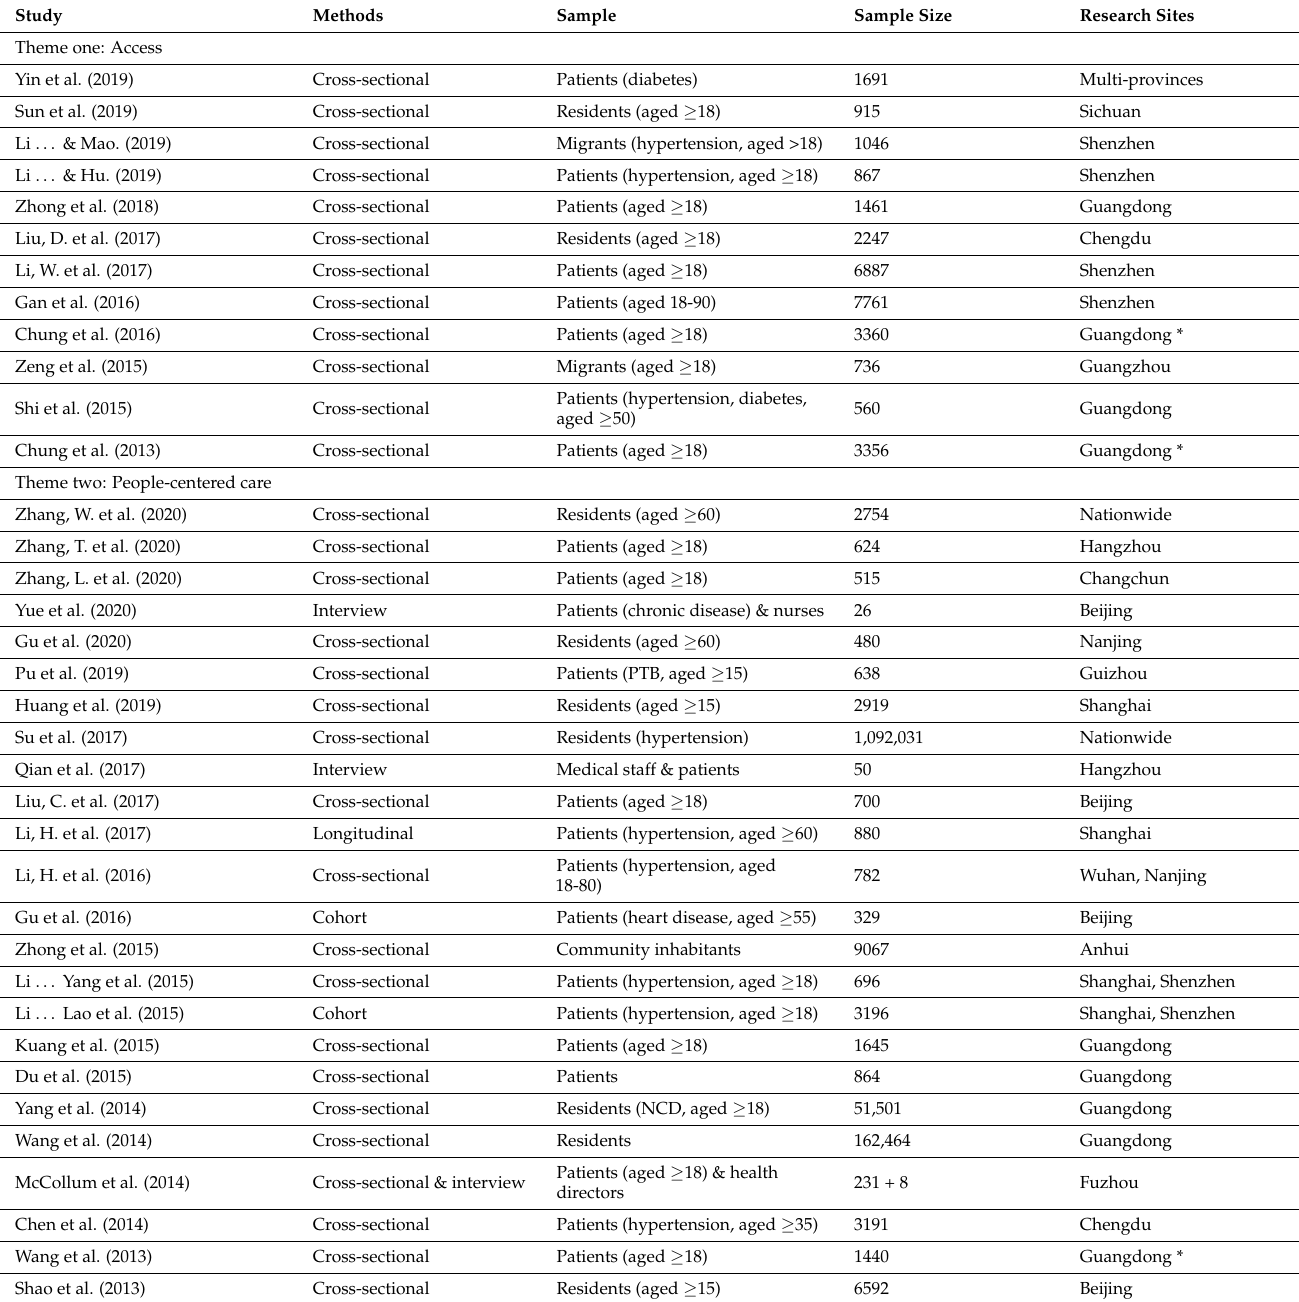
Table 2. Grouping and characteristics of the included